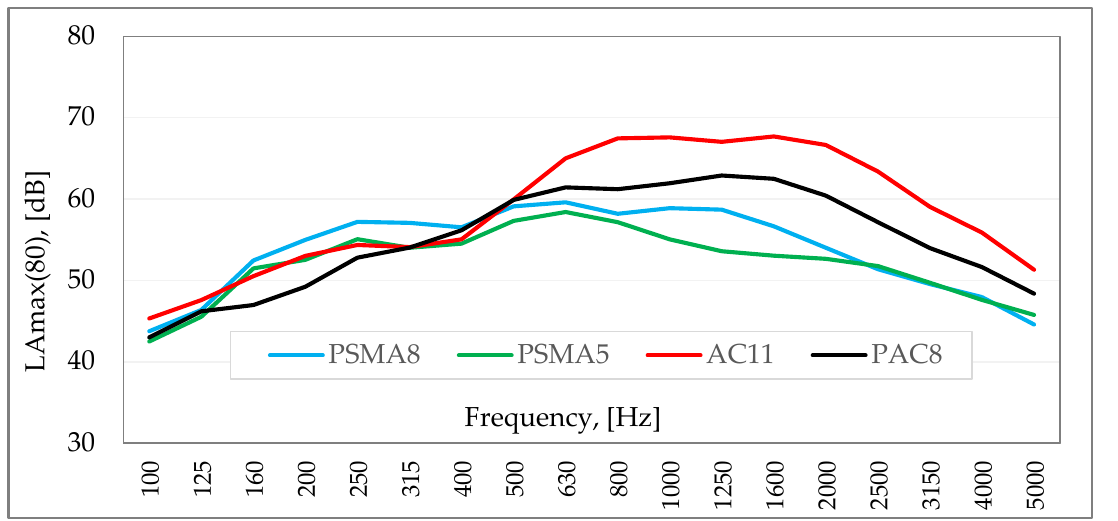
Figure 1. Sound spectra of a statistical passing of a passenger vehicle travelling at a speed of 80 km/h on four surfaces (PSMA8, PSMA5, AC11, PAC8).